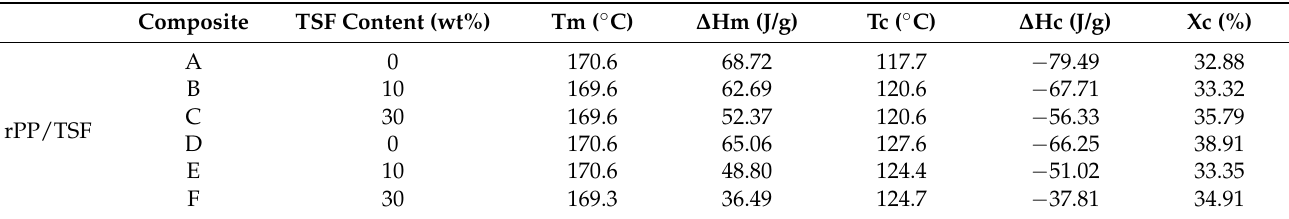
Figure 2. ( a ) composites’ second melting peak temperatures. ( b ) the crystallization peak temperatures of composites. Table 2. Thermal parameters of the investigated composites.